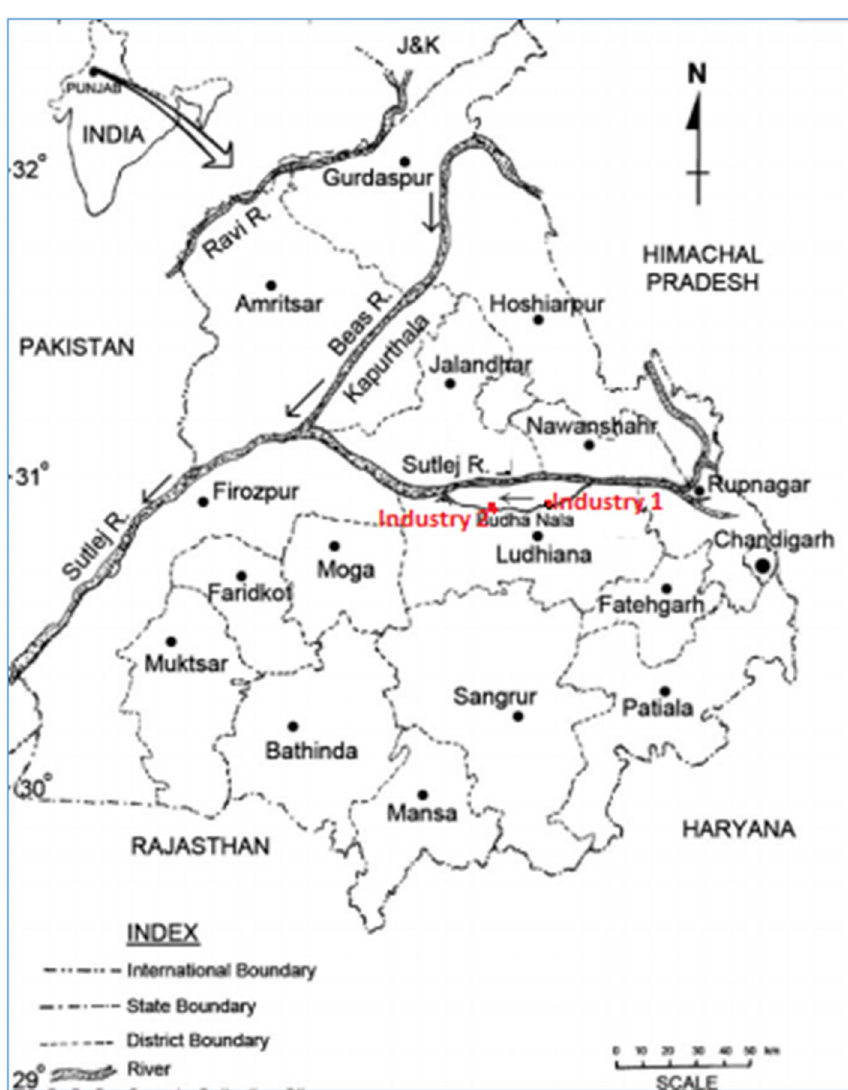
Fig. 1 The map of Ludhiana showing the sampling sites (Site 1 and Site 2, shown in red)